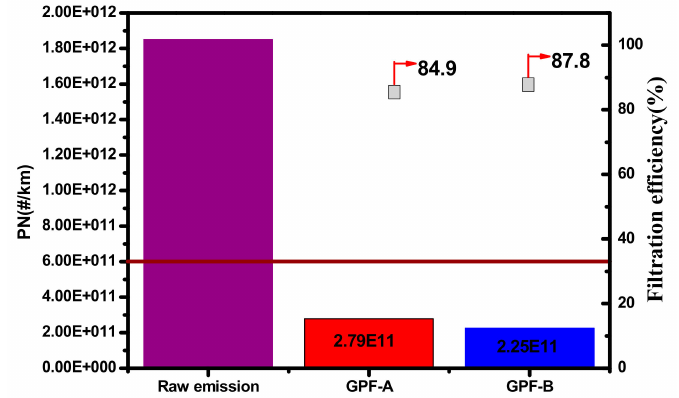
Figure 5. Influence of the washcoat material bulk density on particulate number (PN) filtration e ffi